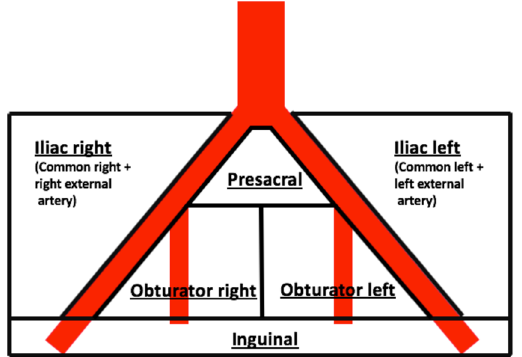
Figure 5. Template of Lymph node stations used in the region-based analysis. This figure shows the template of the lymph node (LN) stations examined in this study. The iliac left and right region included all LN around the common iliac and external iliac artery. The obturator left and right region included all LN around the internal iliac artery and its branches. The presacral region defined the area anterior of the sacrum without strict allocation to vessels. LN of the inguinal region were defined below the inguinal bands.